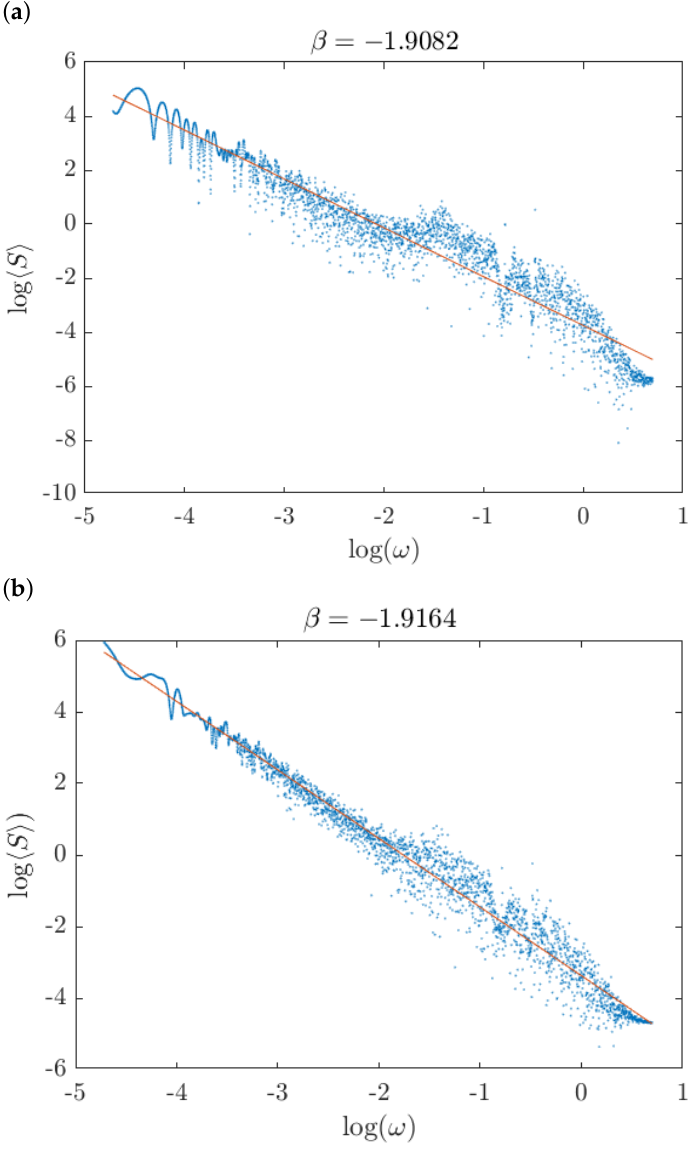
Figure 4. Averaged power spectral density from phase difference θ ( t ) for random initial conditions of the deterministic model with ( a ) κ = 0 and ( b ) κ =